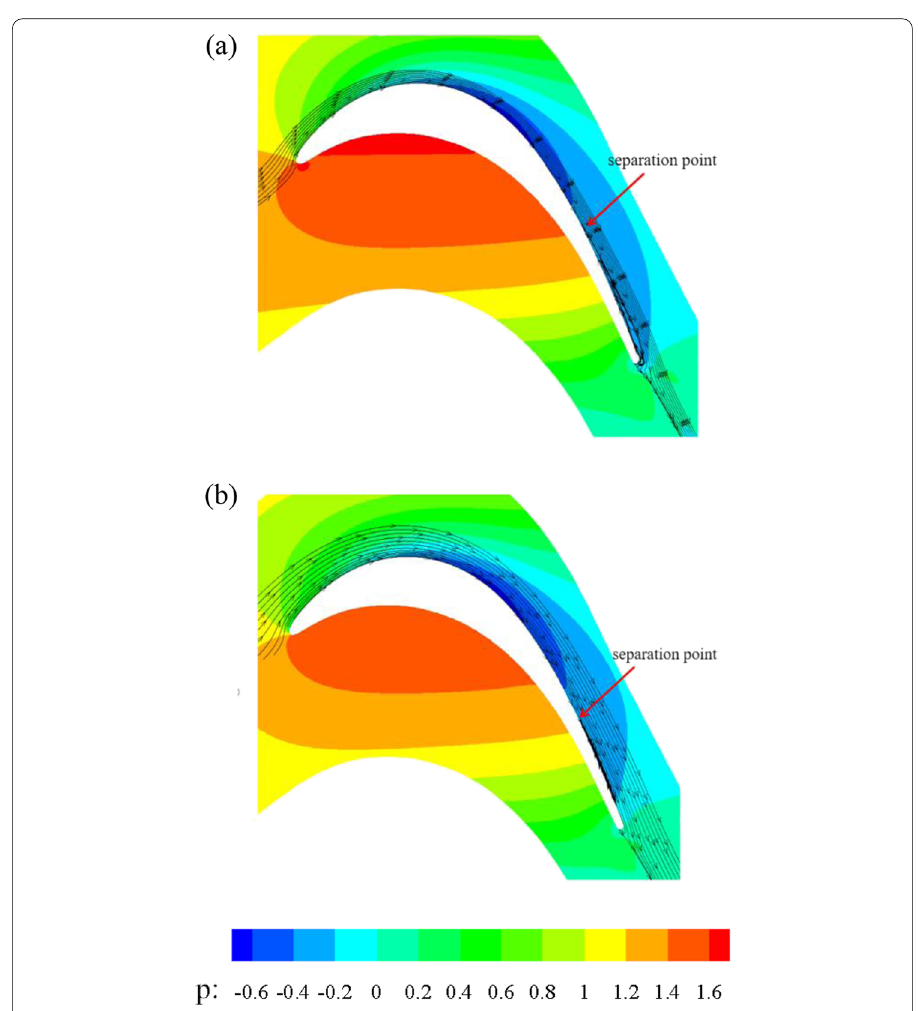
Fig. 7 Time-averaged streamline and pressure contour: ( a ) uniform inflow condition; ( b ) disturbed inflow